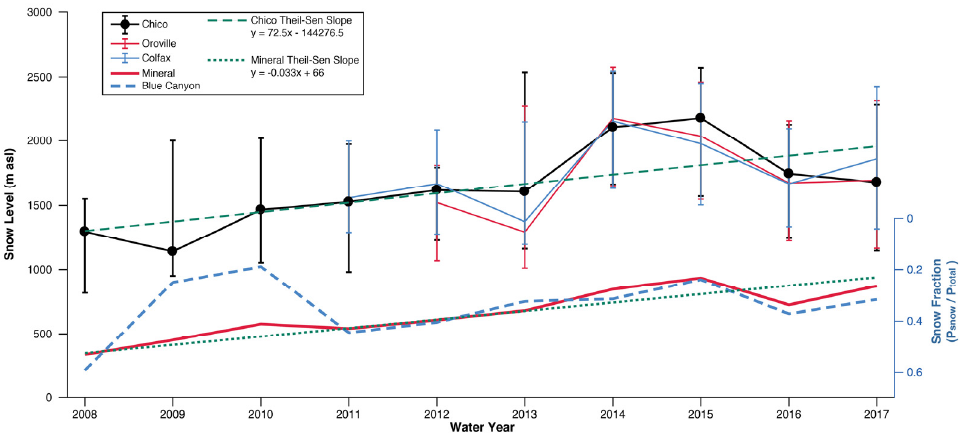
Figure 2. Water year (WY) 2008–2017 snow levels observed by the Chico radar and snow levels observed by the Oroville (WY2012–2017) and Colfax radars (WY2011–2017). Capped bars designate upper and lower quartiles with black dots showing Chico median values. Right y-axis: Snow fractions at the Mineral and Blue Canyon hourly precipitation stations. Note the reversal of the right y-axis such that an upward slope indicates a decrease in snow fraction.